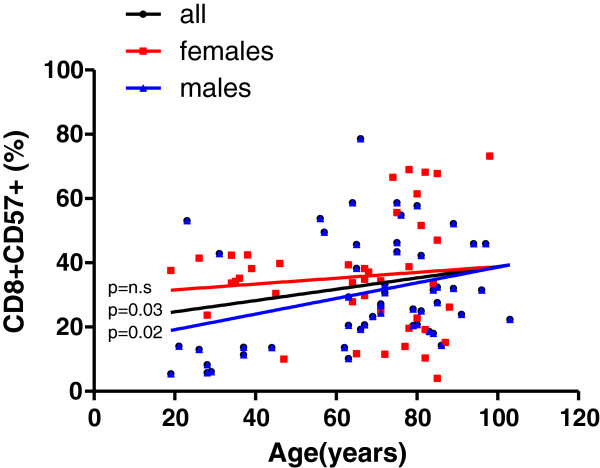
Frequency distribution of CD57+ cells within total CD8+ T cells. The cell markers that PBL were stained for are shown on the Y axis. The linear regression results are represented in different colors for all individuals (black line, n=94), males (blue line, n=52) and females (red line, n= 42). The p values for all individuals are shown on the graphs nearby the regression line, p<0.05 indicates statistical differences.